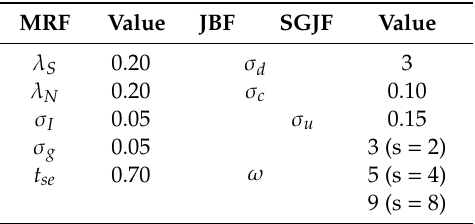
Table 1. SR algorithm